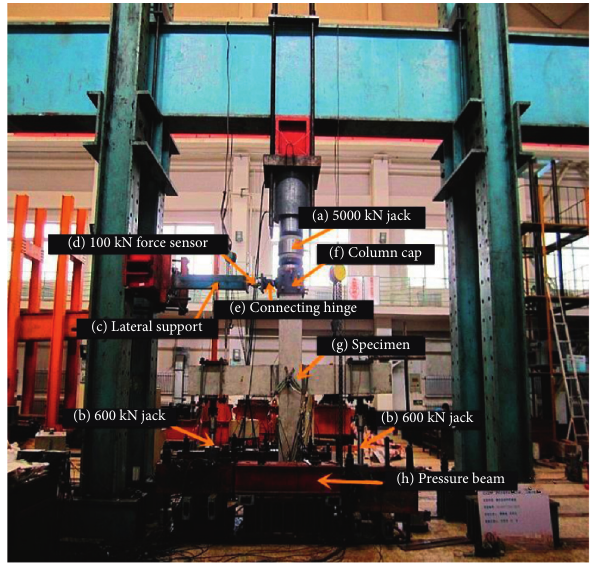
Figure 5: Field loading.